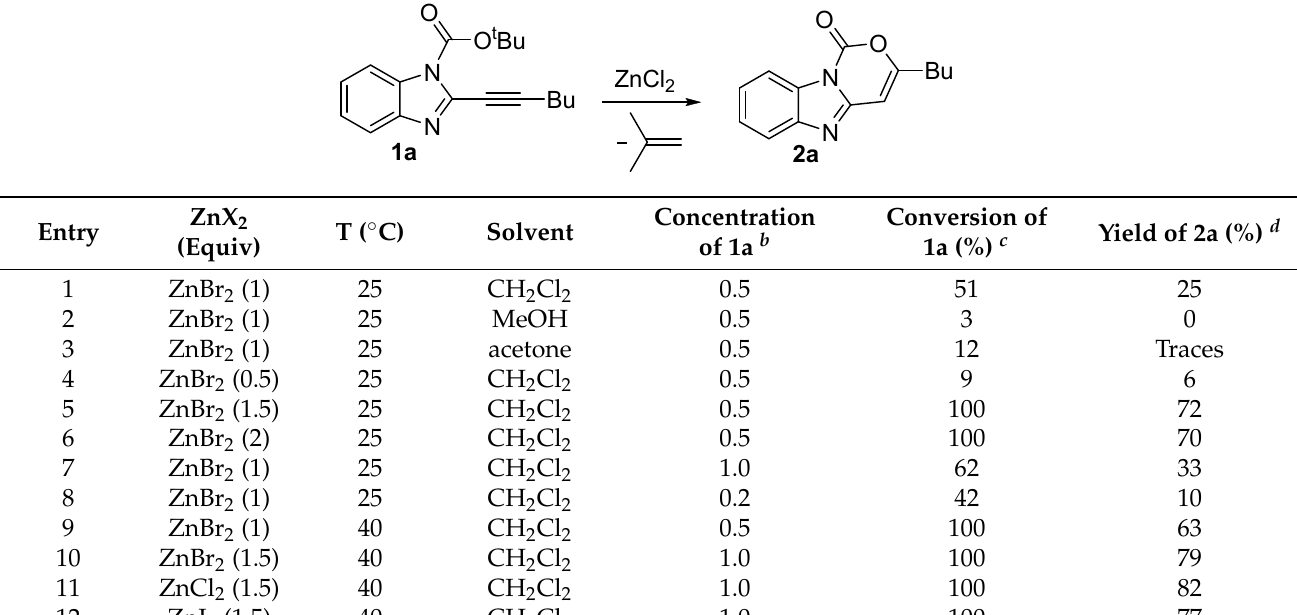
Table 1. ZnX 2 -promoted deprotective heterocyclization of N -Boc-2-(hex-1-in-1-yl)-1 H -benzo[ d ]imidazole 1a under different conditions a .